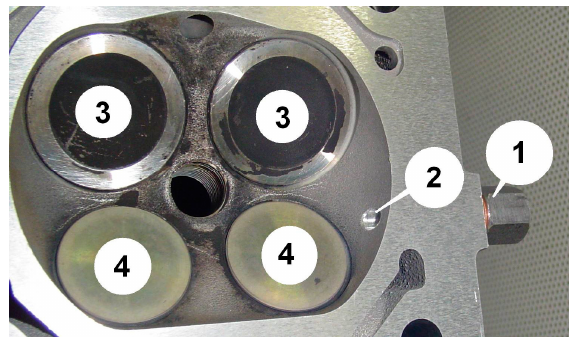
Figure 6. Combustion chamber of the fired cylinder (No. 4); 1—Adapter of the combustion pressure